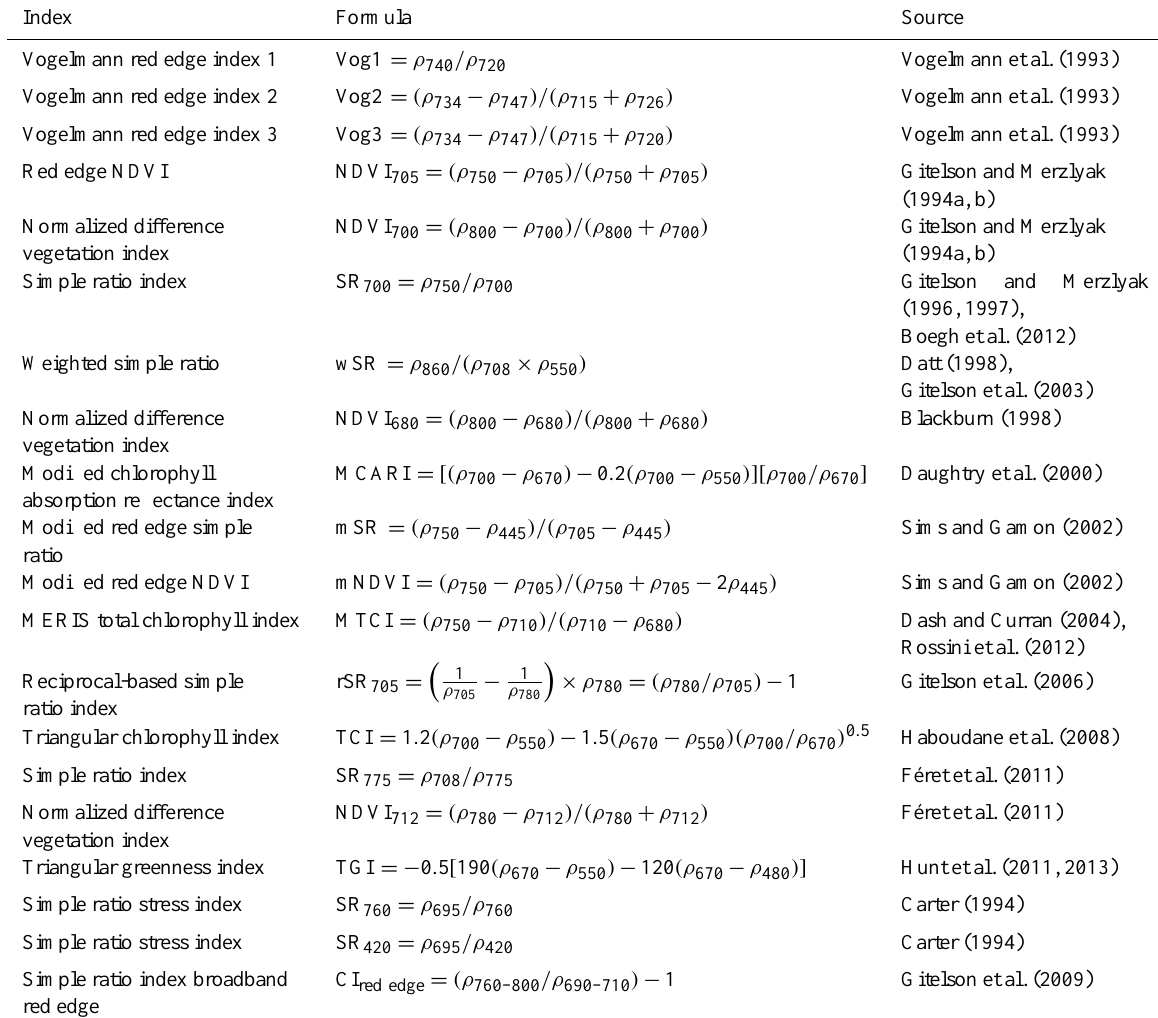
Table 1. Previously developed spectral indices for foliar chlorophyll